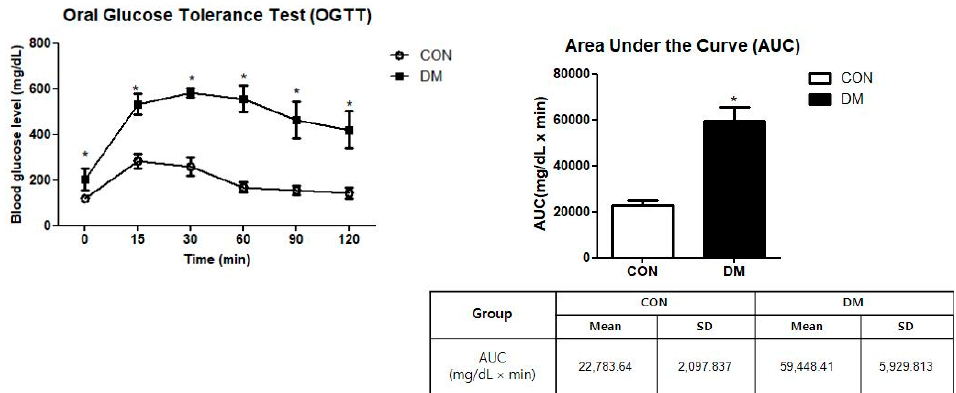
Figure 2. Oral glucose tolerance test in T2DM mice. All values are reported as mean and SD. The asterisk represents statistical significance of differences from * p < 0.05. n = 9 mice in each group. CON, normal control mice; DM, diabetes mellitus mice.